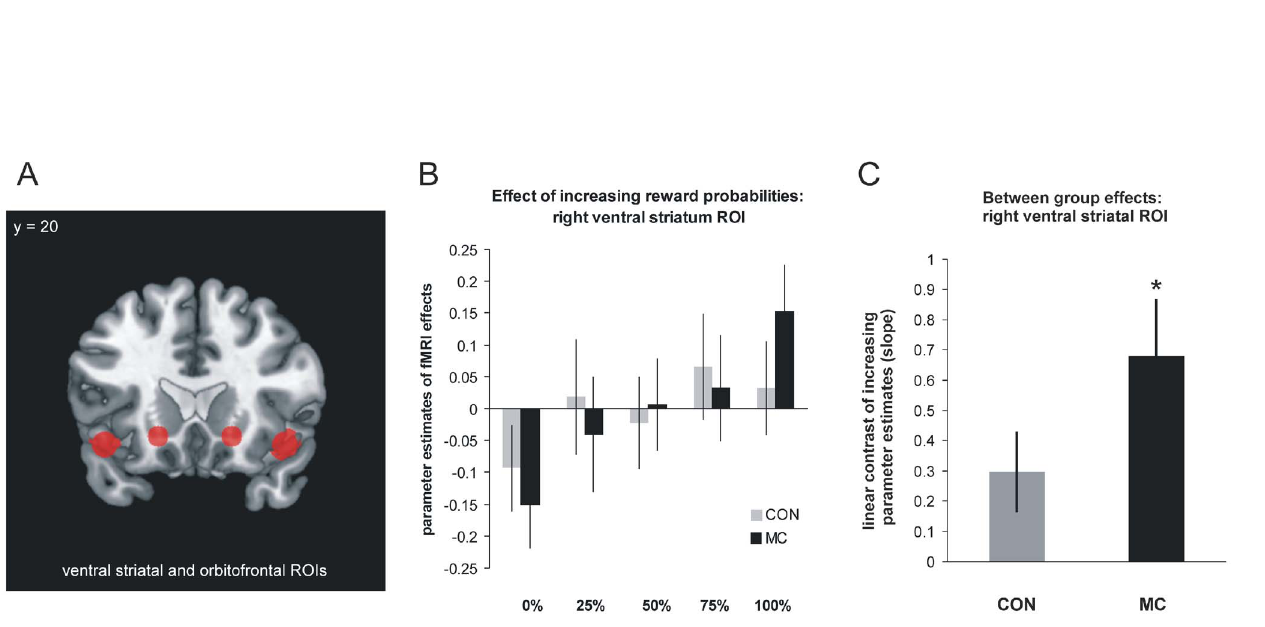
Fig. 3. A - Position of 3-dimensional, independent regions of interest (ROIs): ventral striatum and anterior insula/orbitofrontal cortex (AI/OFC). B - Mean corrected parameter estimates of fMRI effect within right ventral striatum ROI: parameter estimates demonstrate increased differential effects of reward expectation in HD compared to the CON group as an expression of functional compensation. C - Linear contrast (slope) of parameter estimates of fMRI effects within right ventral striatum: mean and standard deviation of individual slopes in each group and significant (*: p , 0.05) group difference. HD: Huntington disease mutation carriers, CON: control